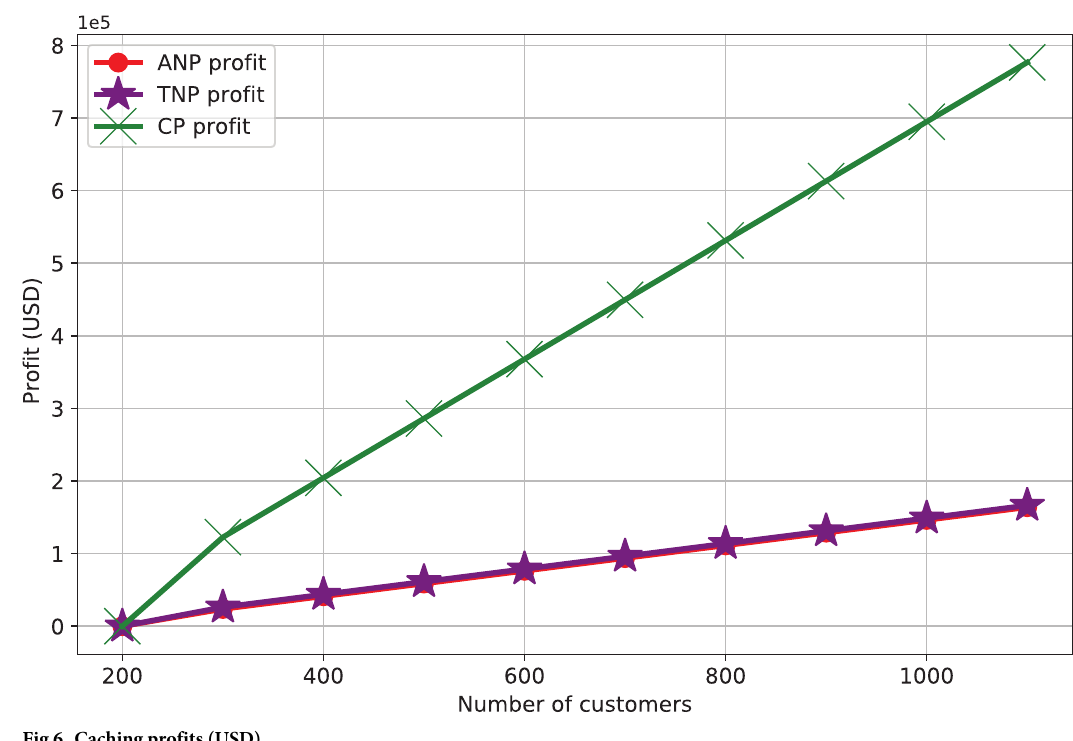
Fig 6. Caching profits